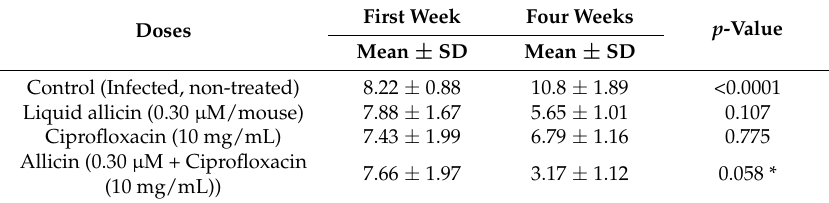
SD: Standard Deviation * Significant at p <